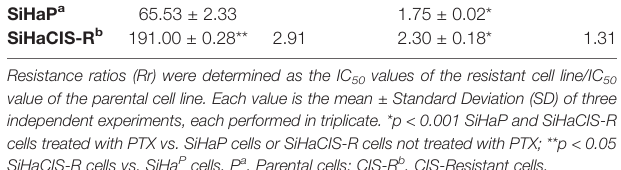
TABLE 3 | Resistance to Cadmium Chloride in SiHaP and SiHaCIS-R cervical cancer cell lines. Cell Lines